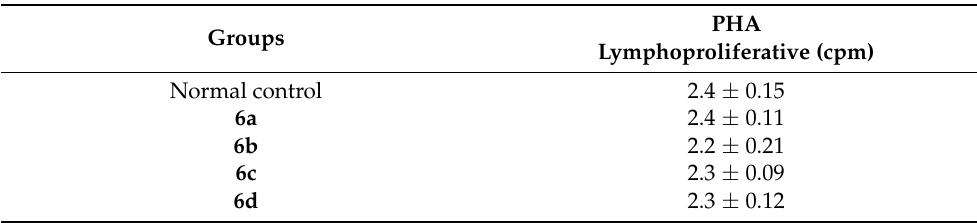
Table 9. Lymphoproliferative response to phytohemagglutinin mitogen (cpm) in normal control and indoloquinoline derivatives bearing